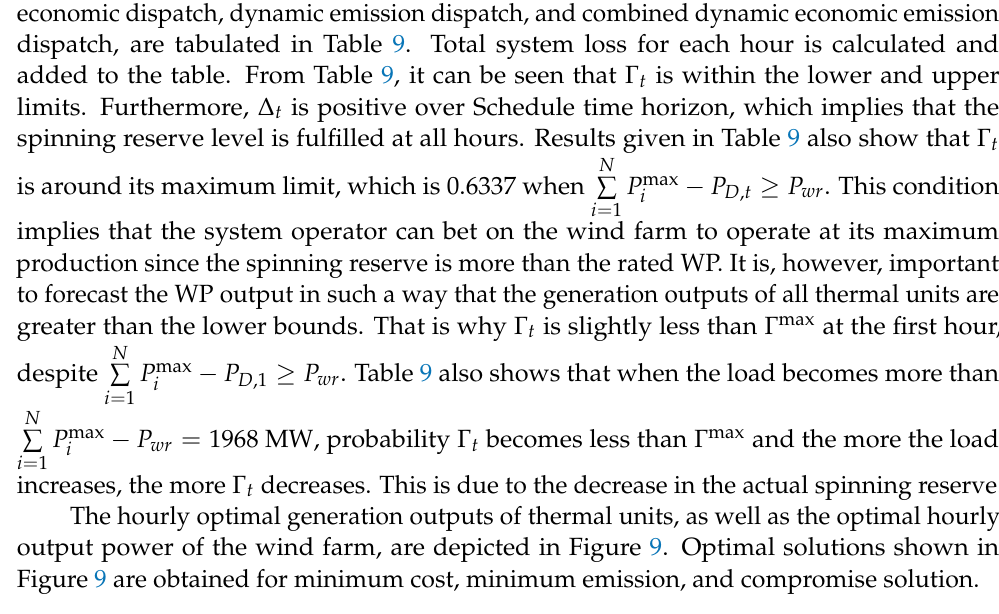
Figure 9. Hourly variation of wt  .